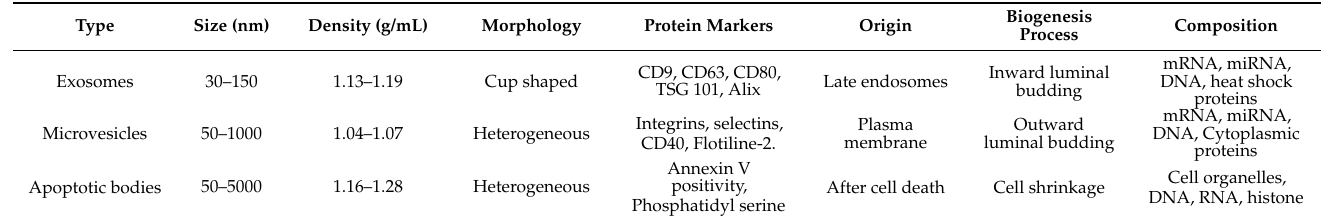
Figure 1. The composition of the typical exosome. Exosomes are nano-sized extracellular vesicles composed of a phospholipid bilayer, proteins such as TSG 101, Integrins, Alix, HSP, nucleic acids such as miRNA, mRNA, DNA, and many other receptors. Table 1. Classification of EVs based on their size, biomarker, and biogenesis